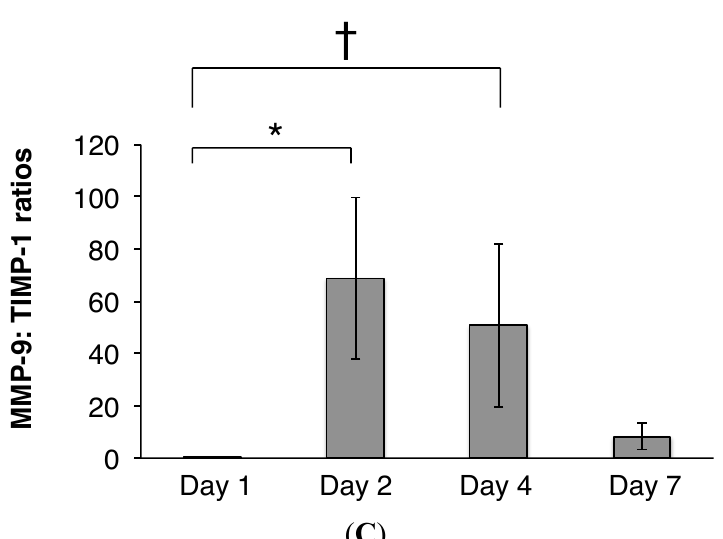
Figure 3. ( A ) RSV titer PI in wild-type (WT) C57BL/6 mice with time of infection. RSV was detected consistently in BALF by 24 h after inoculation. The highest viral titer was measured on day 2 PI (3.2 ± 0.3 log PFU/mL vs . 0.6 ± 0.2 log PFU/mL on Day 1), and 10 10 remained increased on day 4 (2.6 ± 0.2 log PFU/mL). By day 7, the viral titer was 10 decreased by approximately 3 logs (0.4 ± 0.3 log PFU/mL), and similar to that detected 10 on day 1. n =20 mice; 5 mice per group x 4 separate experiments, for each time point. Data represent mean ± SEM. * p < 0.001 and † p = 0.004 as indicated, by ANOVA followed by Tukey-Kramer multiple comparisons test; ( B ) Total MMP-9 concentration peaks on day 2 post RSV inoculation. Total MMP-9 concentration measured in BALF of RSV infected WT mice